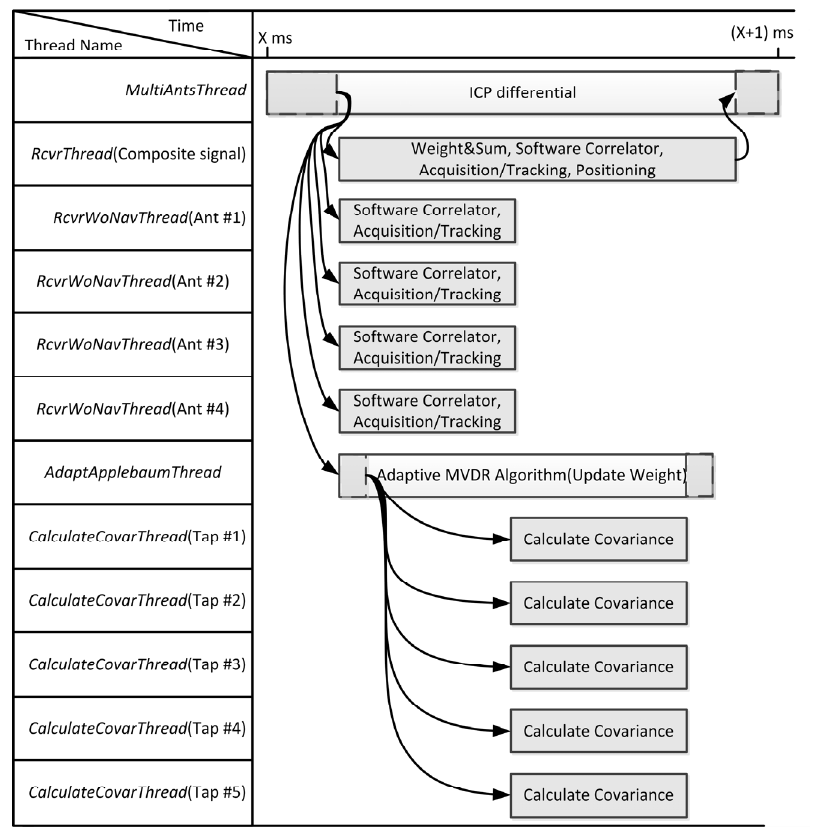
Figure 11. Execution flow of the software receiver within 1 ms. Multithread programming is used to make the software capable of real-time